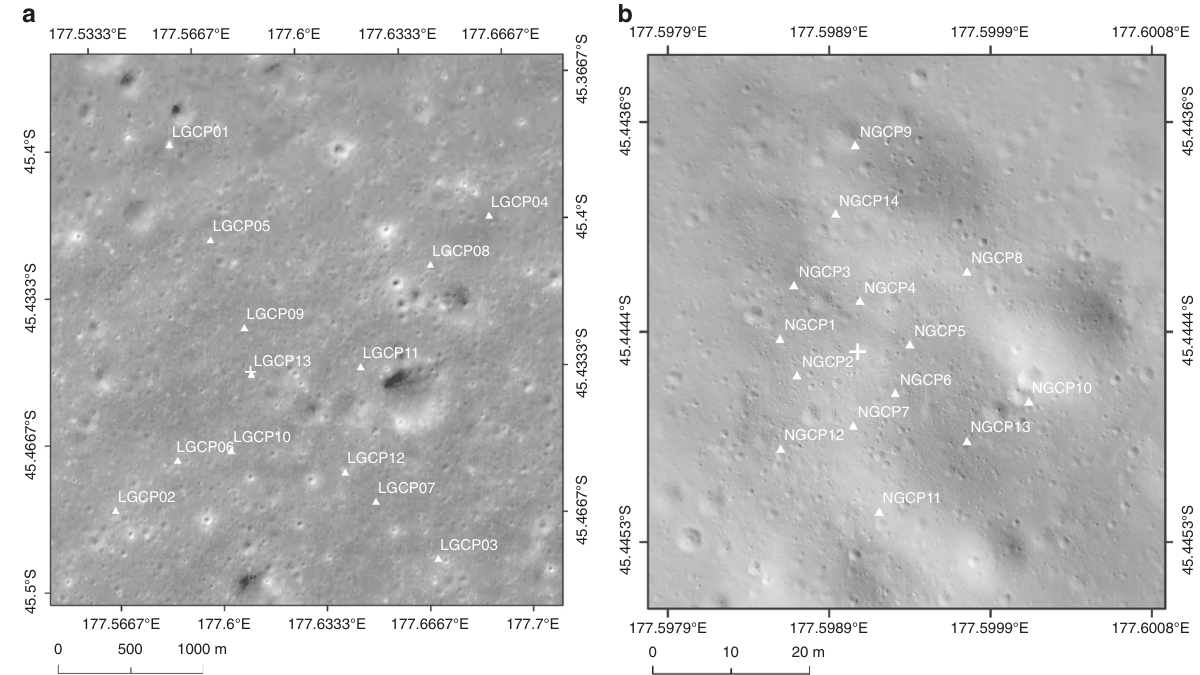
Fig. 2 GCPs map for photogrammetric adjustment processing. a GCPs on the CE2TMap2015 DOM for the LCAM image adjustment, marked as LGCPs, in which LGCP13 is the vertical GCP; b GCPs on the LCAM DOM for the NCAM image adjustment, marked as NGCPs. The + is the landing site